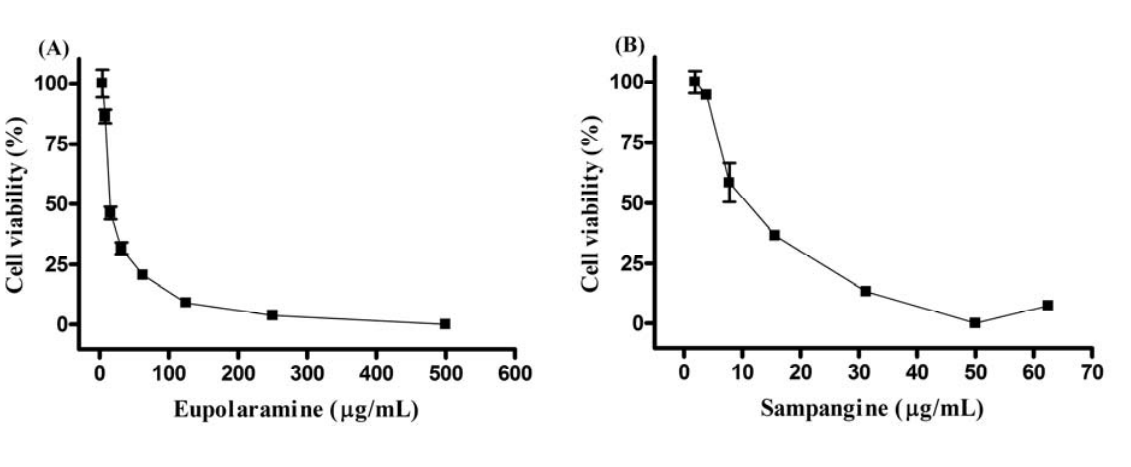
Figure 2. Celular viability after the treatment with the alkaloids eupolauramine ( A ) and sampangine ( B